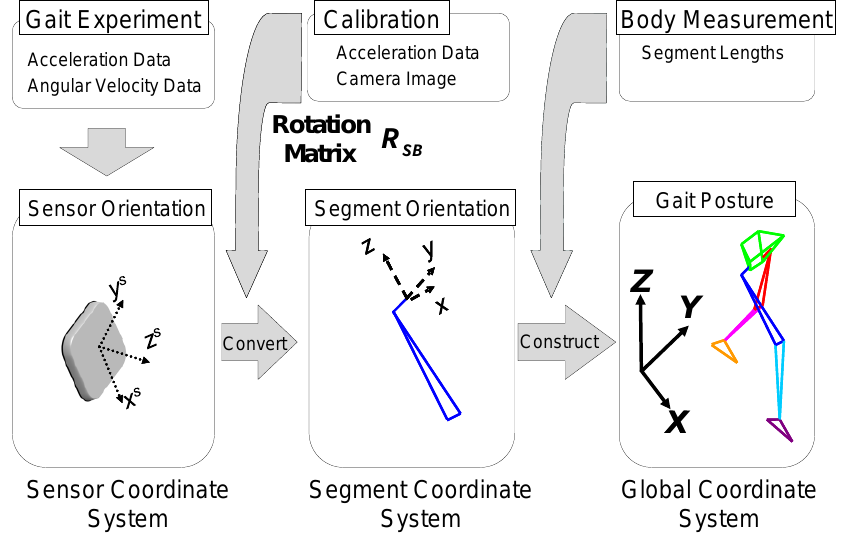
Figure 4. The process flow of gait experiment for visualization of gait motion using a gait wire frame model. Acceleration and angular velocity data from the sensor coordinate system are converted to be expressed in the body segment coordinate system using rotation matrix R . Gait motion on the wire frame model is constructed by segment orientation and SB